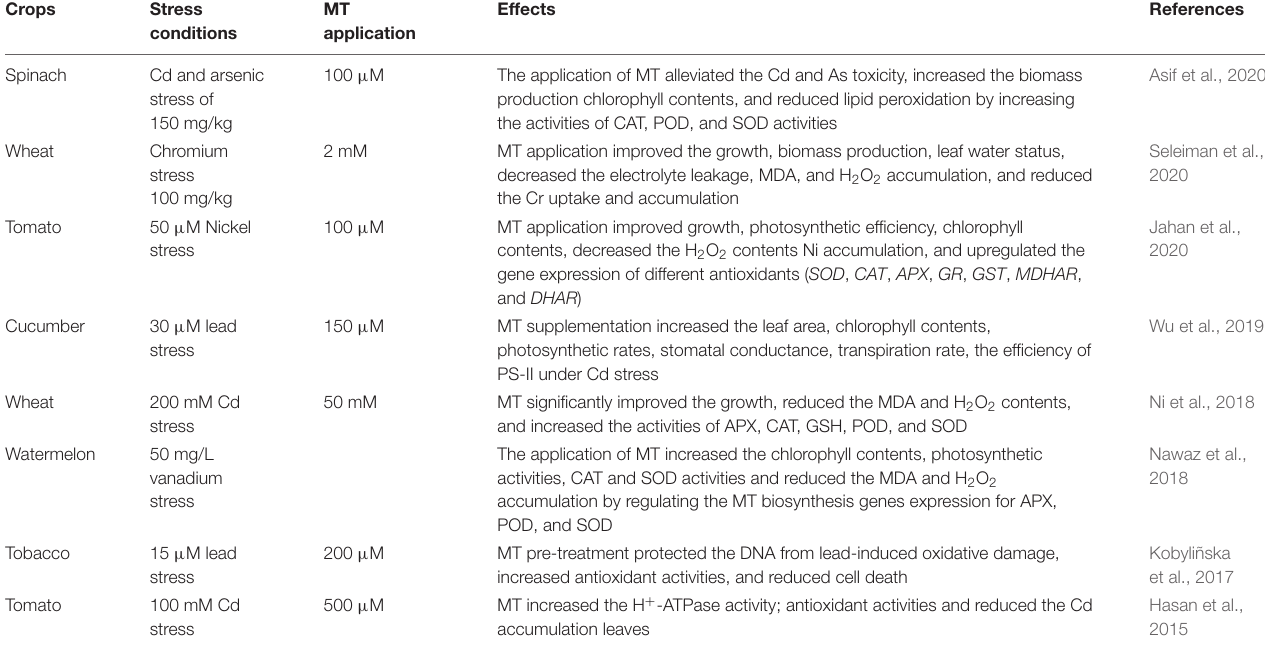
TABLE 5 | Role of melatonin in inducing heavy metals stress tolerance in different plant